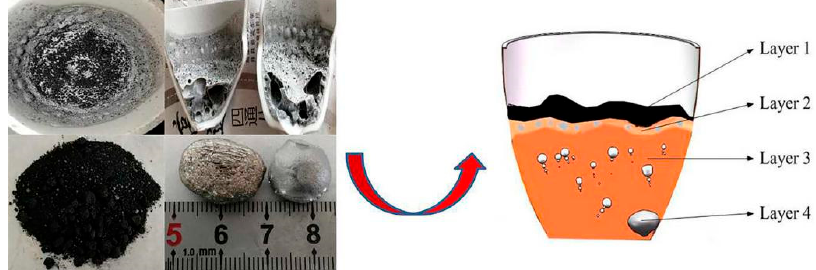
Figure 5. Phenomena of stratification for the residue after reduction at the experimental temperature with more than 3% CaF 2 .